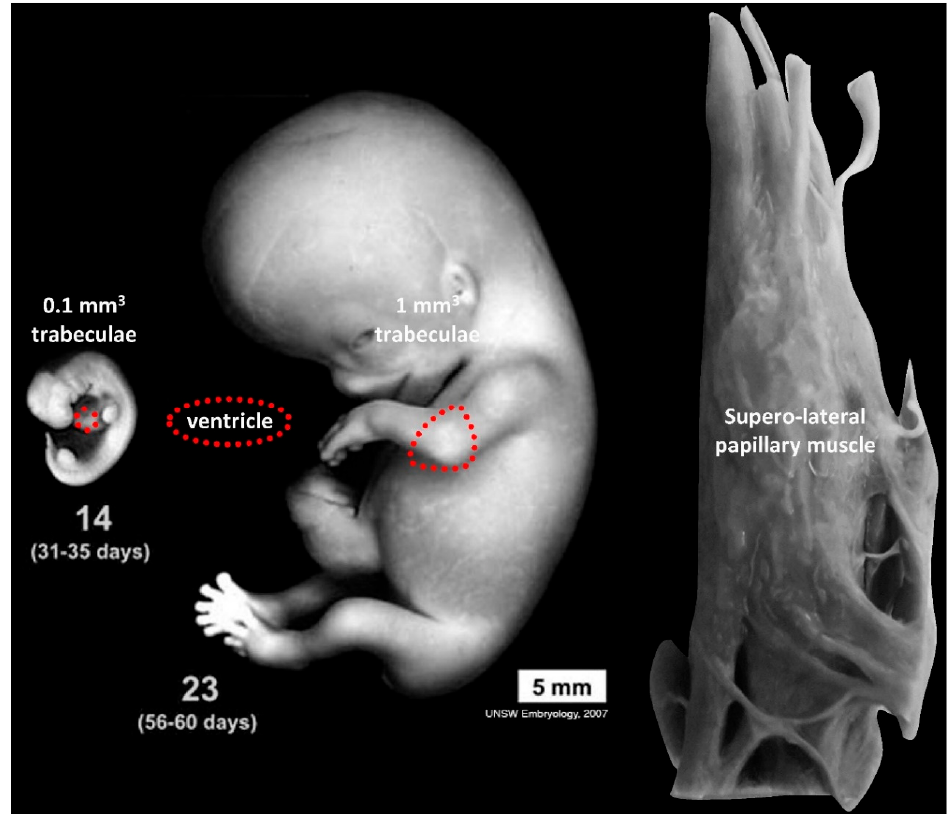
Figure 3. Growth of the cardiac ventricle (dashed red line) from a proportionally very trabeculated stage (14) to the end of embryonic development where compaction is presumed to have taken place (23) compared to the superior-lateral papillary muscle of the adult heart (which develops from embryonic trabeculae). From Carnegie stages 14 to 23, the volume of trabecular muscle increases approximately an order of magnitude [85] and then approximately five orders of magnitude to reach 10 g in the adult heart [69] (note that [85] included the ventricular septum in the volume of trabeculae and the numbers we show are a bit lower than in [85]). Images of embryos are adapted from Hill,